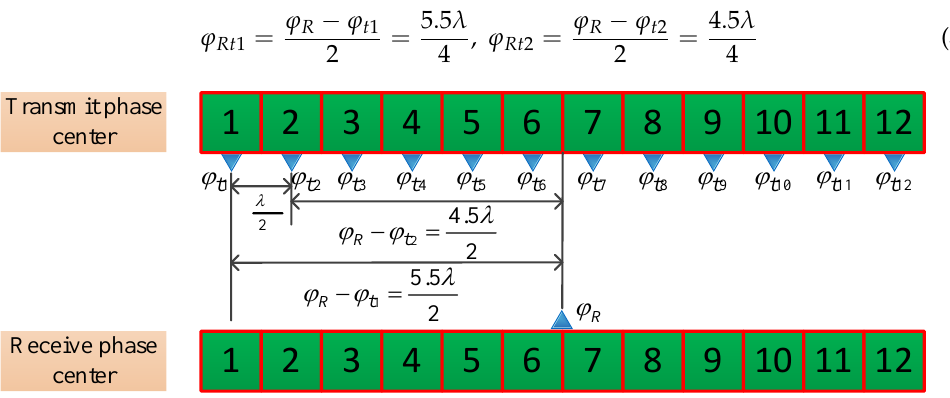
Figure 3. Schematic of transmit and receive phase centers.